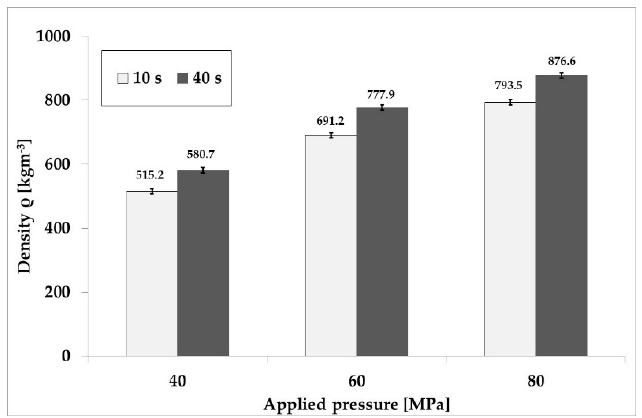
Figure 4. Average compacts density values (kg m − 3 ) obtained by compressing hop cones with three compression pressure levels (40, 60 and 80 MPa) and two pressure application times (10 and 40 s). Error bars indicate standard error ( n = 5).